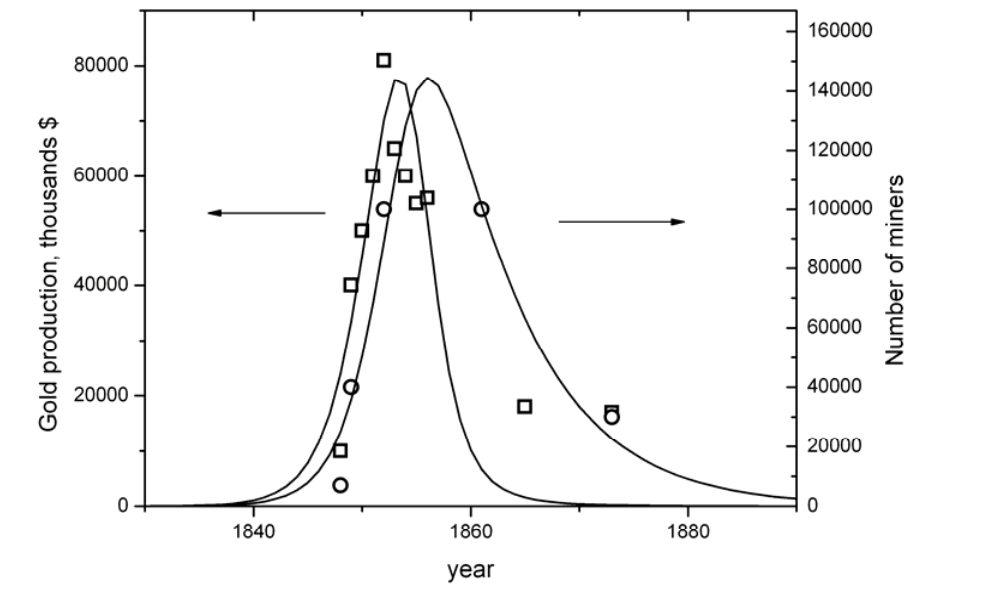
Figure 3 . Gold production and number of miners during the “Gold Rush” in California fitted using the LV model developed here. The data are from